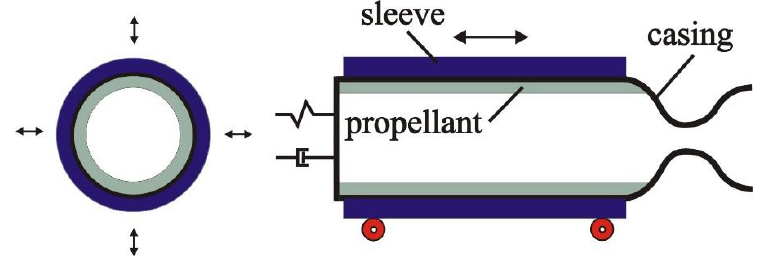
Figure 1. The reference solid-propellant rocket motor (SRM) model setup, for static test firing in the